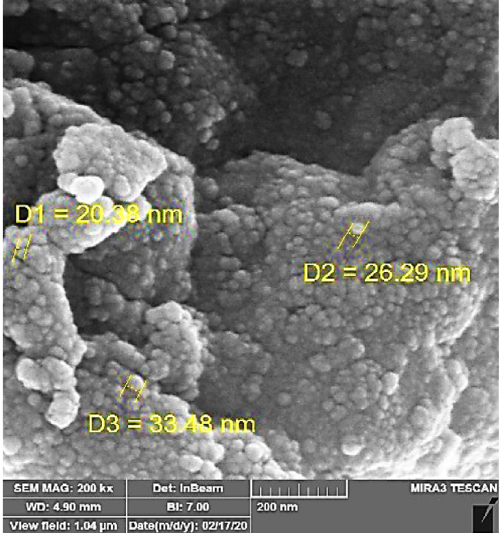
Figure 5. The SEM contains the size of Fe 3 O 4 @CPTMO-phenylalanine-Ni.